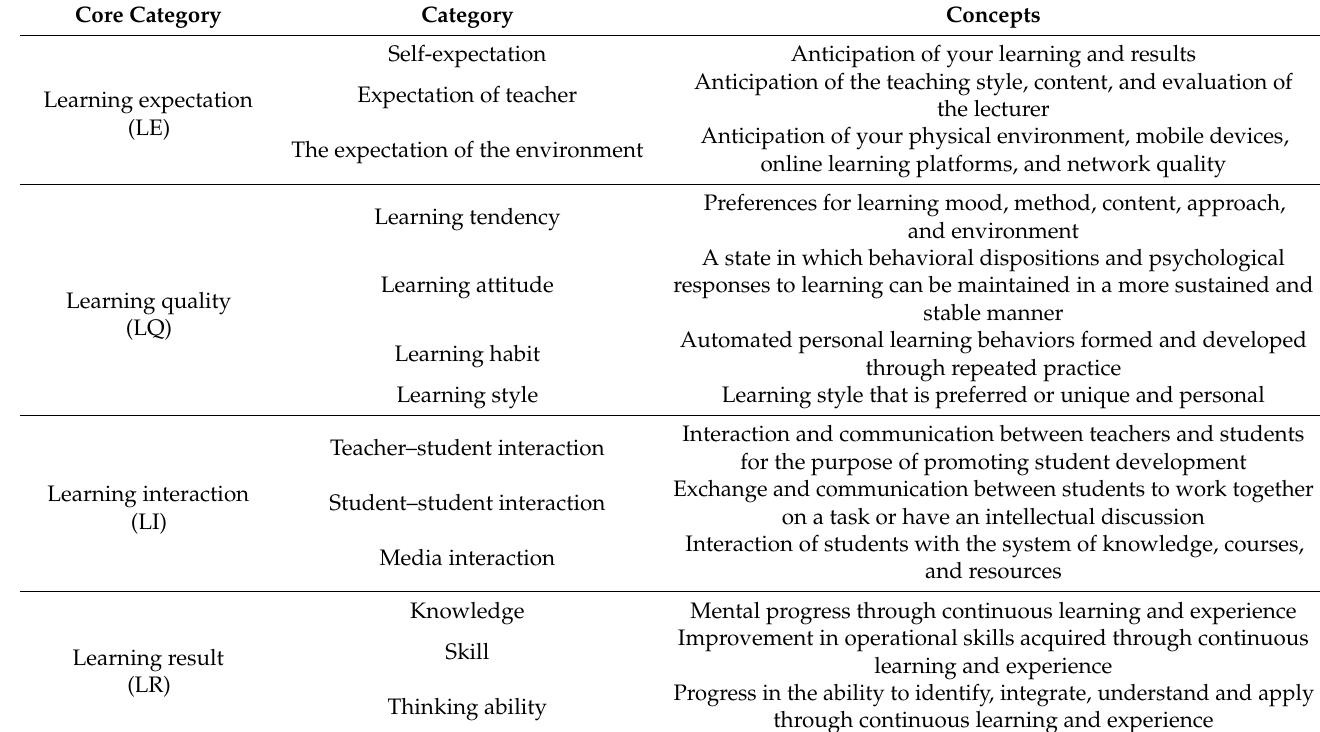
Table 1. Results of coding